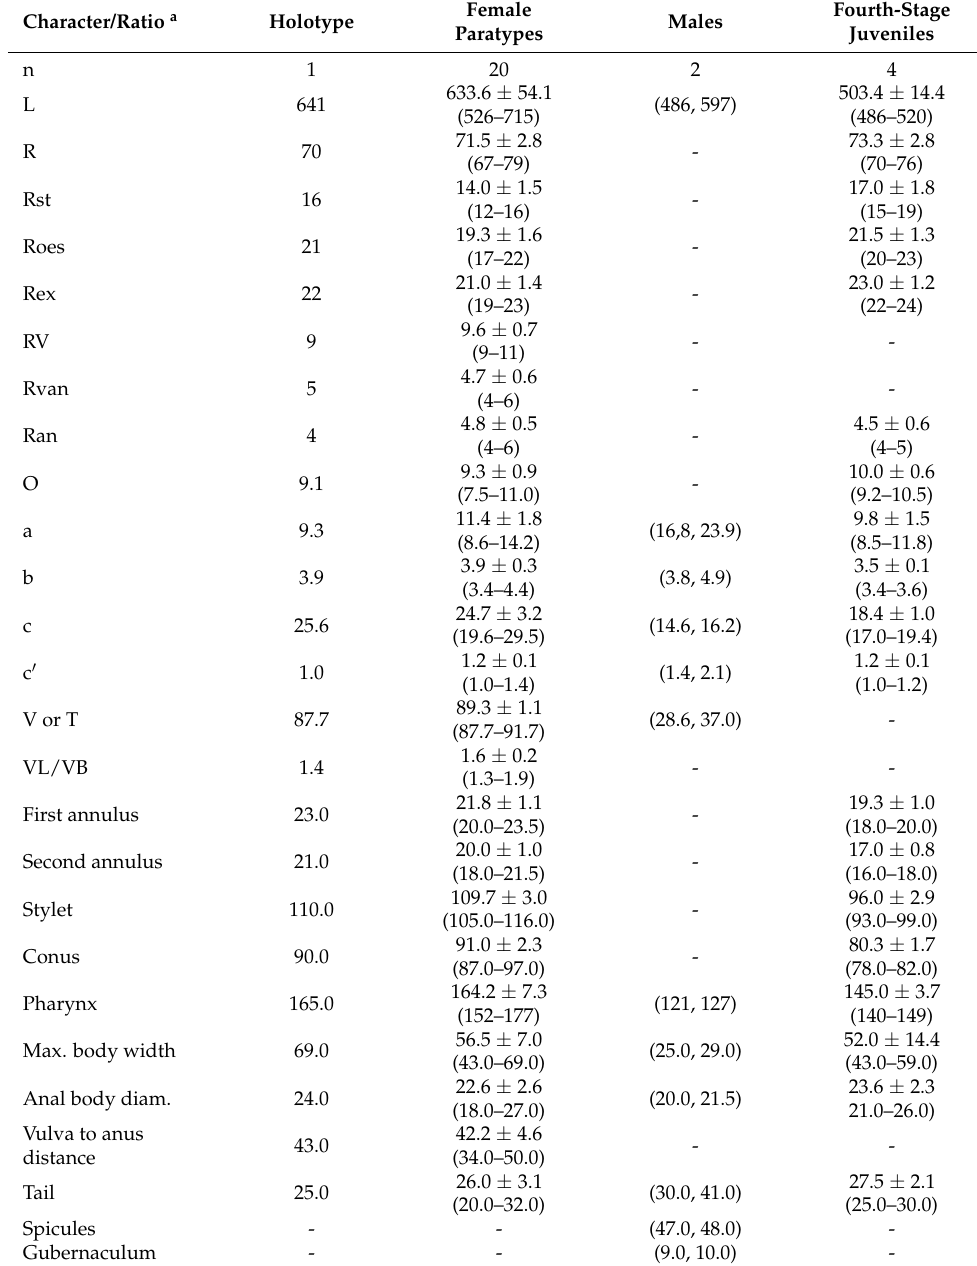
Table 3. Morphometrics of Criconema pseudoannuliferum sp. nov. from the rhizosphere of maritime pine ( Pinus pinaster Ait.) in Casares, M á laga province, Spain. Character/Ratio a Holotype